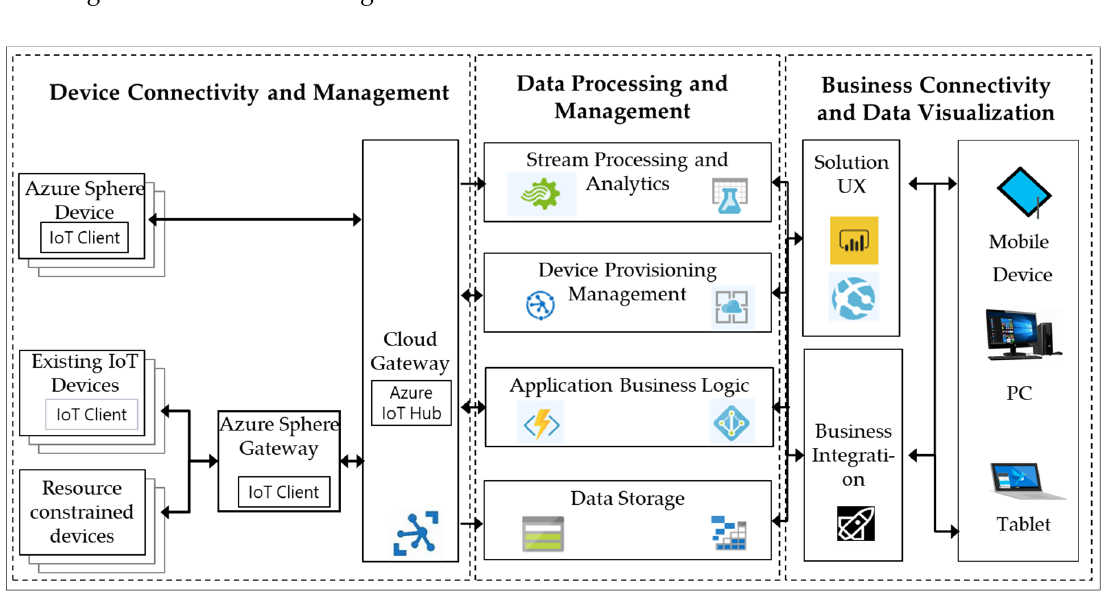
Figure 1. System overview.